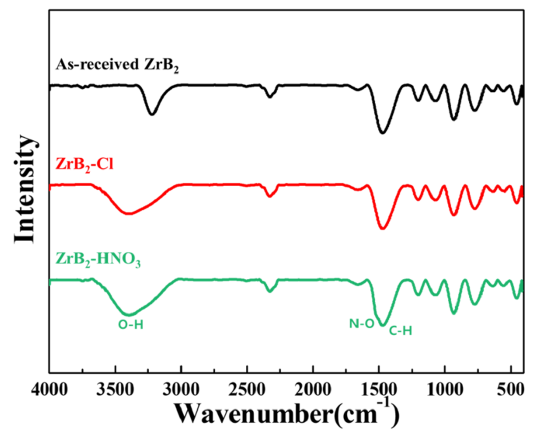
Figure 5. Fourier transform infrared (FT-IR) spectra of as-received ZrB 2 , HCl-treated ZrB 2 , and HNO 3 -treated ZrB 2 particles.